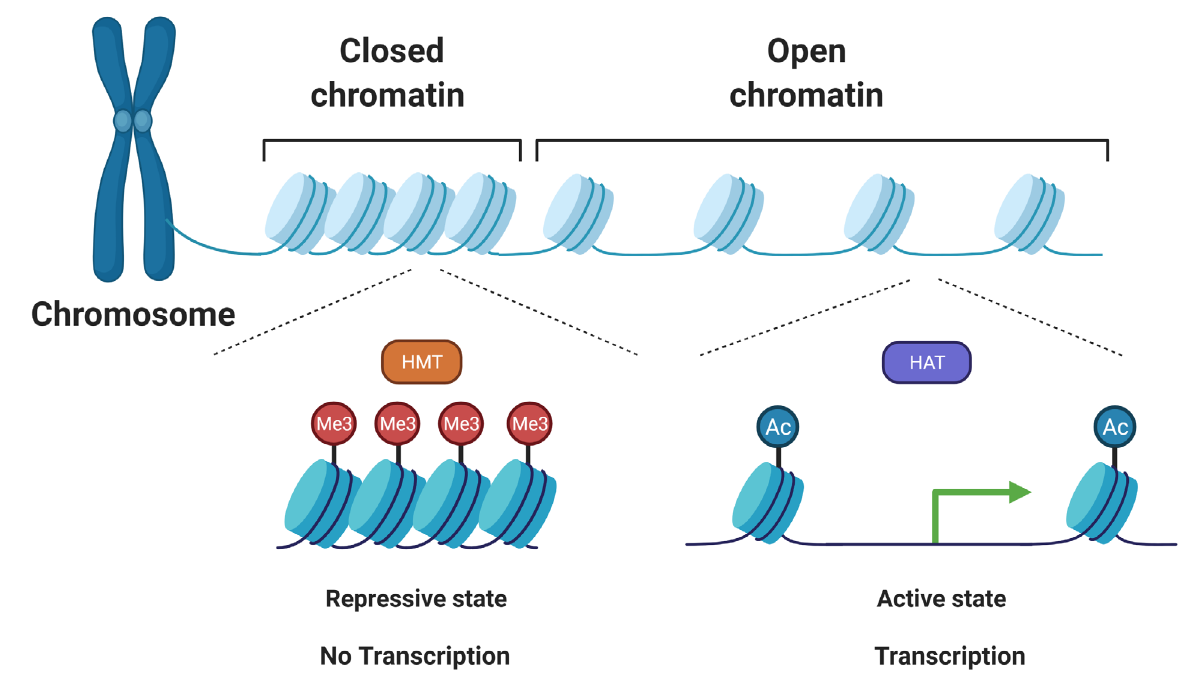
Figure 3 – Histone modifications and their impact on chromatin remodeling. Histone methylation is catalyzed by histone methyltransferases (HMTs), resulting in chromatin packaging (heterochromatin) and a repressive state (no transcription). Conversely, histone acetylation by histone acetyltransferases (HATs) results in open chromatin (euchromatin) associated with an active transcriptional pattern. Adapted from “Epigenetics and gene expression”, by BioRender.com (2022). Retrieved from